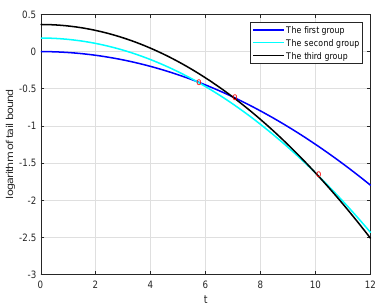
Figure 1. The logarithm of the one sided tail bound of three different group selection of parameters k with n = 4 in Example